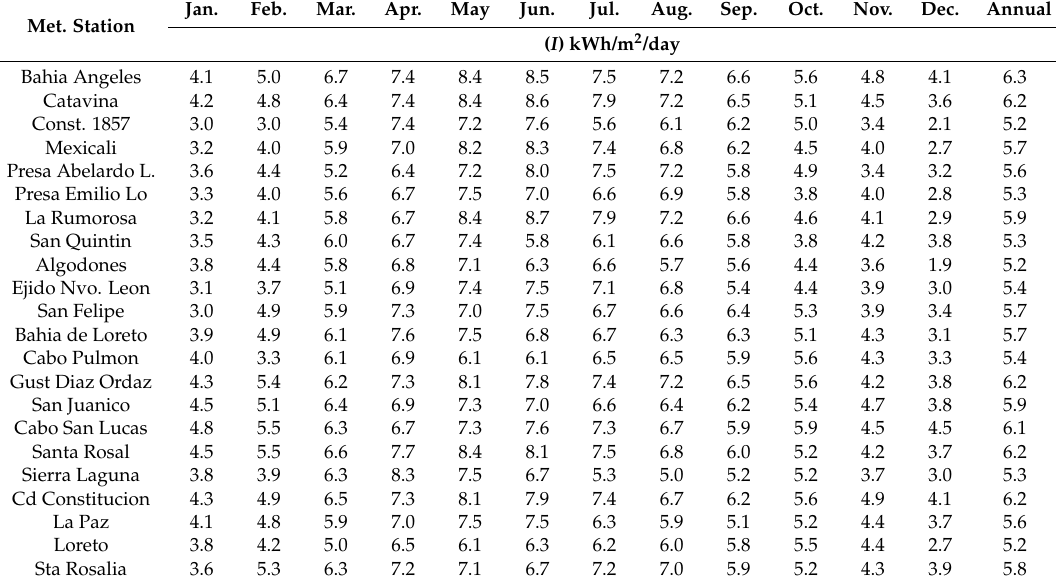
Table 3. Monthly and annual irradiation per meteorological